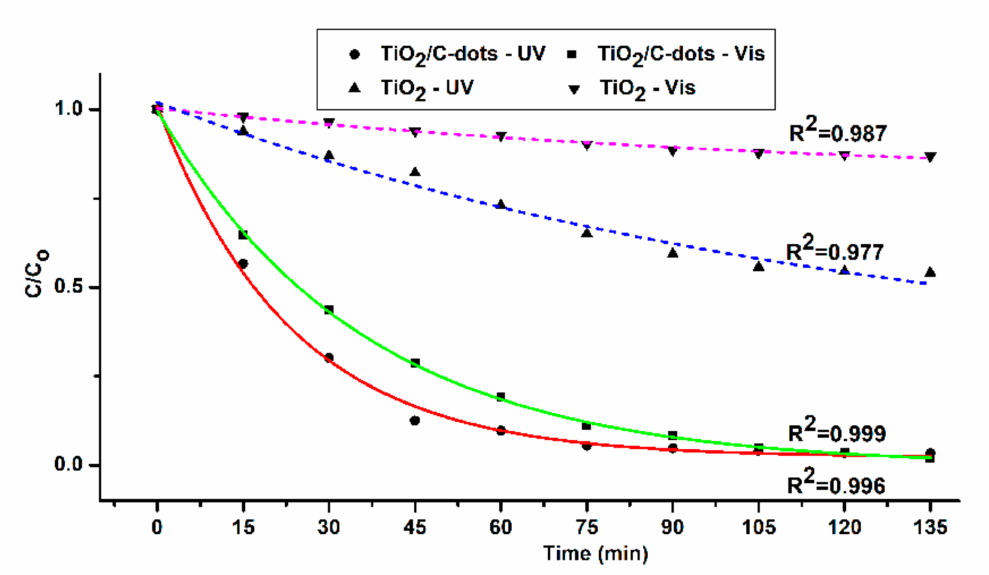
Figure 11. Photocatalytic degradation curves of MO by TiO 2 and TiO 2 enriched with C-dots under UV and visible